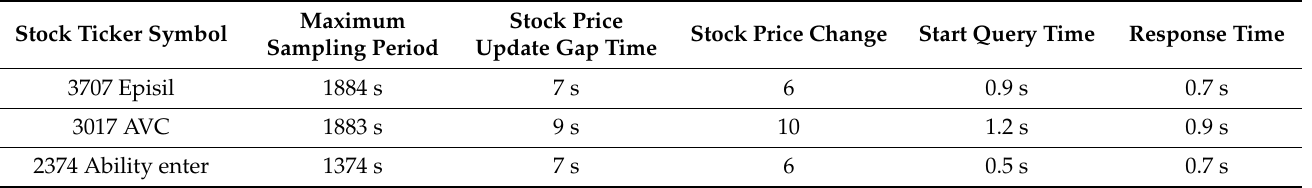
Table 4. Ticker symbol stock price sample